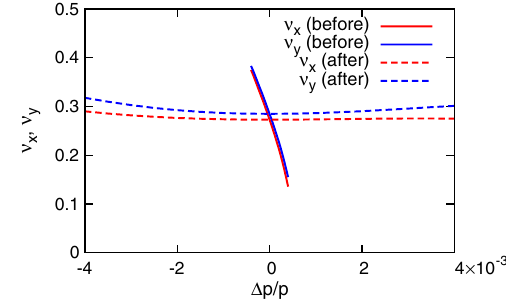
FIG. 6. Momentum dependence of the horizontal (cid:8) x (red) and vertical (cid:8) y (blue) fractional betatron tunes before (solid lines) and after (dashed lines) the linear chromaticity compensation.